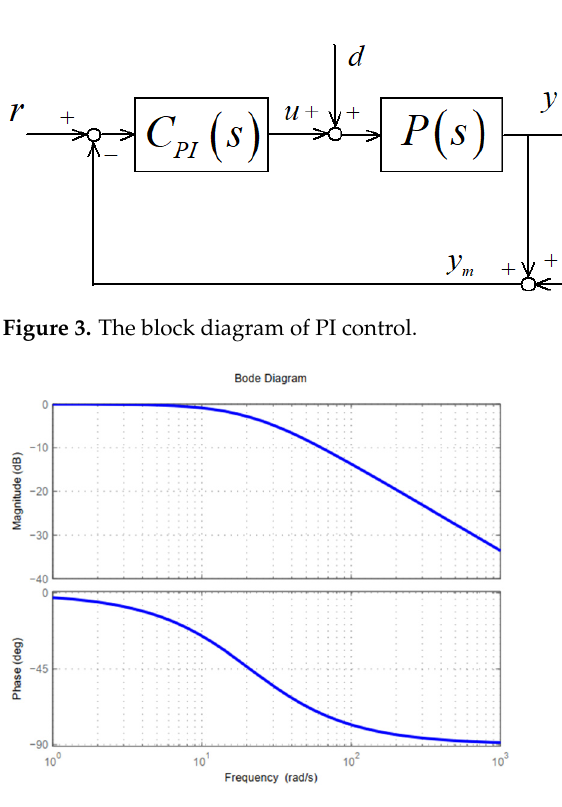
Figure 4. Typical Bode diagram of F L ( s ) , where l 1 = 1, β 1 = 20.